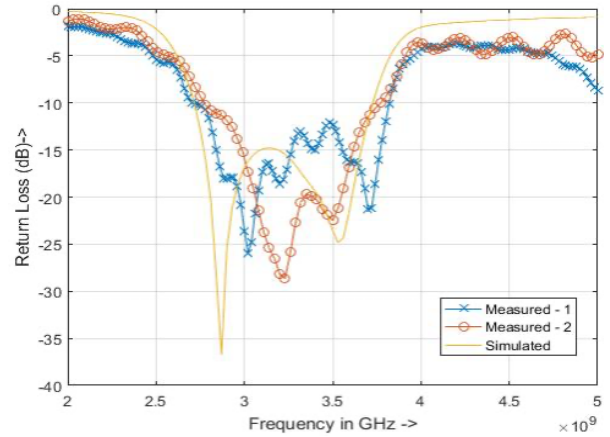
FIGURE 3. Comparison of Simulated and Measured Return